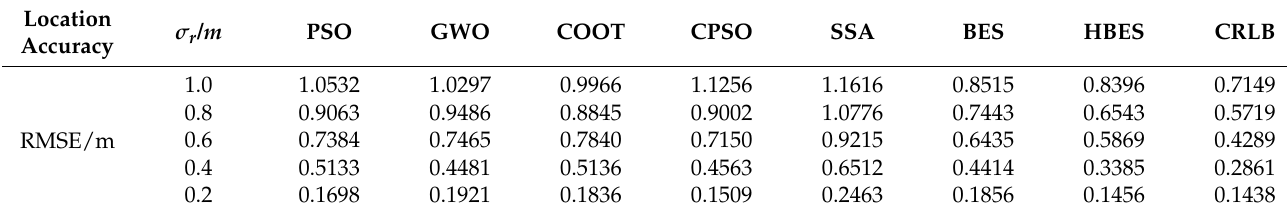
Table 5. Localization accuracy comparison of a different number of base stations.